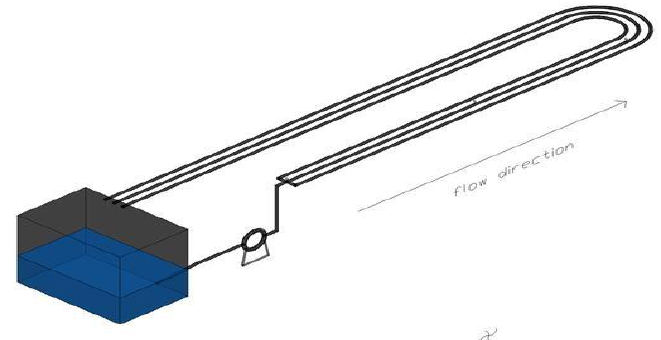
Figure 2. Schematic of the experimental rig.